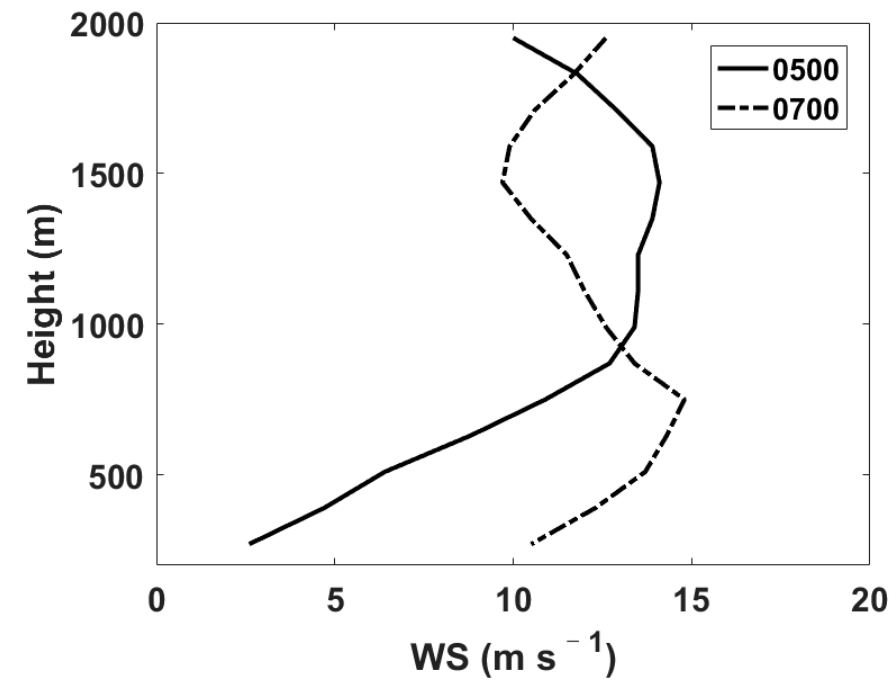
Figure 6. Wind profile at 0500 and 0700 LST 22 December 2016.